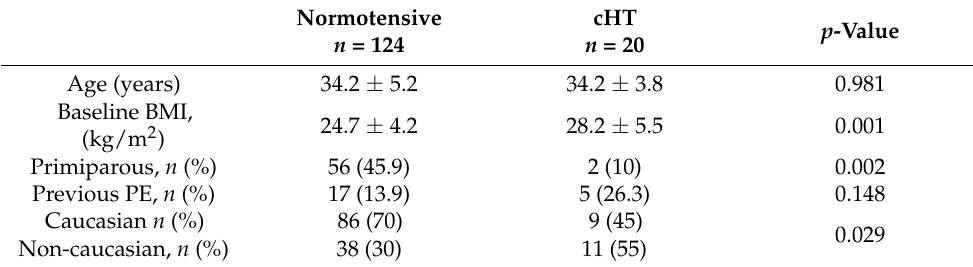
Table 1. Baseline characteristics of the study population in the first trimester.